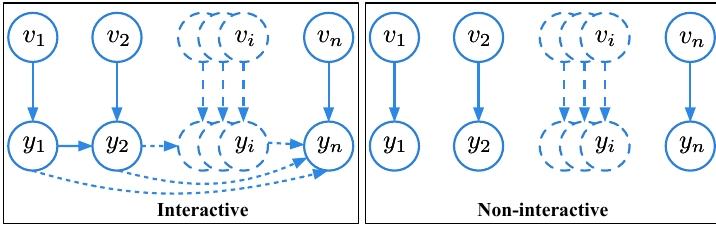
Figure 3. LDP model settings.